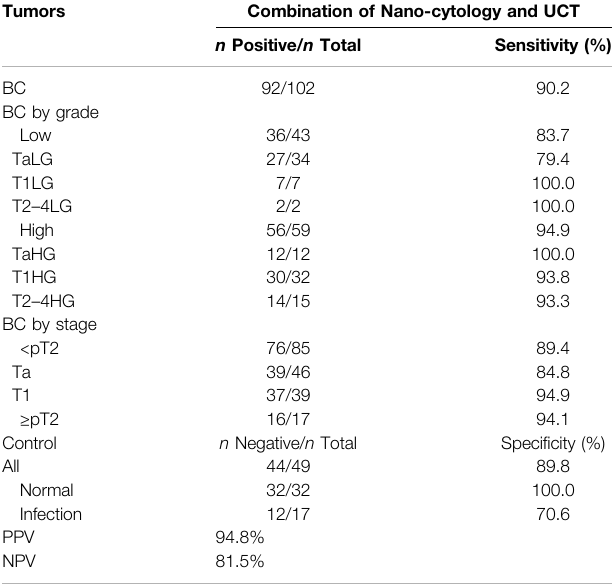
TABLE 3 | Detailed comparison of sensitivity obtained by Nano-UCT for BCa detection in relation to tumor stages and grades. Tumors Combination of Nano-cytology and